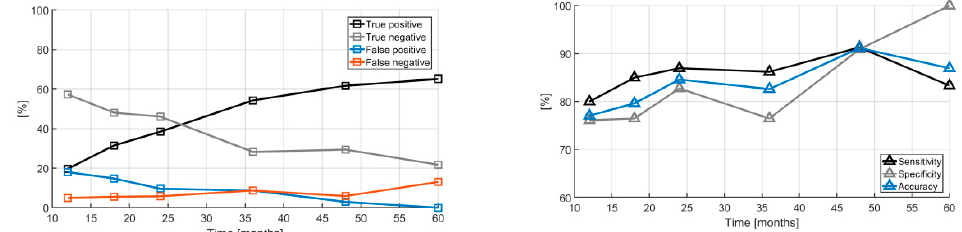
Figure 4. An inverse Kaplan–Meier plot is shown illustrating the fraction of patients obtaining a partial molecular response (50% reduction relative to baseline) during the 60 months of measurement. Figure 5. The “confusion matrix” of model trajectories showing whether the Cancitis model correctly classifies the patient as having a partial molecular response (left). The true positives increase as more data are obtained while the true negatives decrease. The sensitivity, specificity, and accuracy of the Cancitis model are illustrated in the right panel.